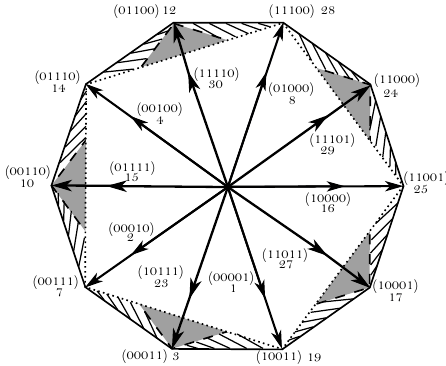
Figure 7. HAZSL5M5-PWM. White: AZSL5M5-PWM with odd vectors; shadowed: AZSL5M5-PWM with even vectors; lines: